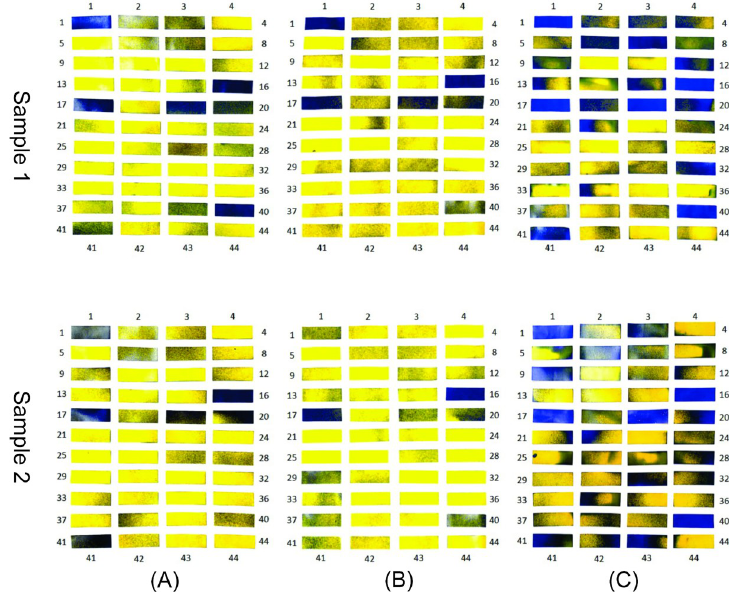
Fig 22. WSPs applied to the body and exposed to the biocidal agent (12 nozzles). (A) Exposed for 10 s without turning; (B) Exposed for 10s with turning in the center; (C) Exposed for 30 s with turning in the center.